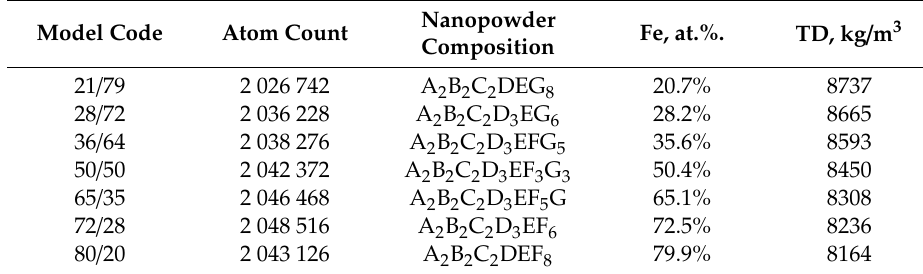
Table 2. Model Fe–Cu nanopowders used in the simulations. Di ff erent Fe / Cu ratios were obtained by mixing A to G nanoparticles in di ff erent